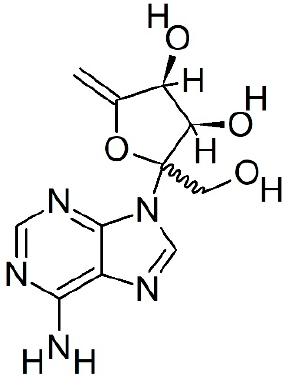
Figure 6. Chemical structure of decoyinine (DCY).